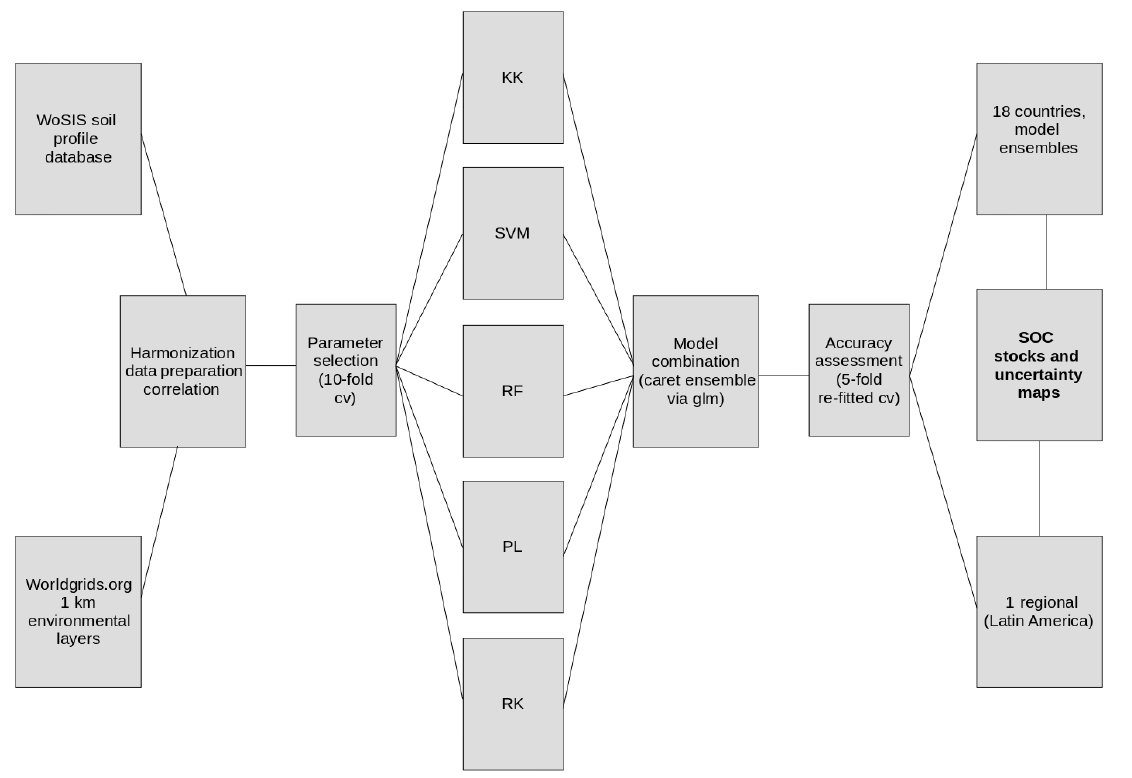
Figure 1. Flow diagram of the main methodological steps that we performed in order to generate country-specific and regional SOC predic- tions. The World Soil Information Service (WoSIS) dataset was harmonized with the http://worldgrids.org (last access: 20 February 2018) environmental data using 5 × 5km grids. SOC stocks were calculated at points and correlated predictors identified. Five methods were pa- rameterized and we created an ensemble of using a generalized linear approach. Accuracy of models and the ensembles was assessed with re- peated cross-validation. Country-specific and regional (Latin America) ensembles were compared with global models. KK is kernel-weighted nearest neighbors, SVM is support vector machines, RF is random forests, PL is partial least squares regression, and RK is regression